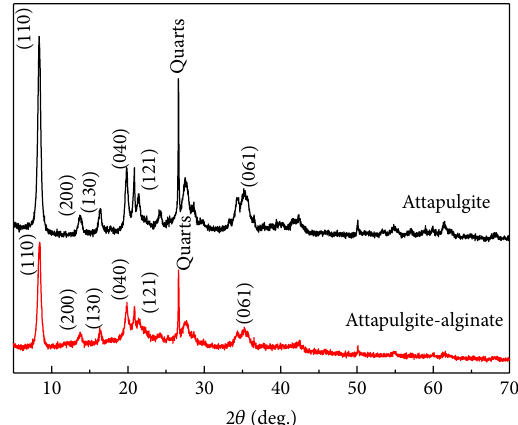
Figure 3: FTIR spectra of sodium alginate, attapulgite, and AC2.